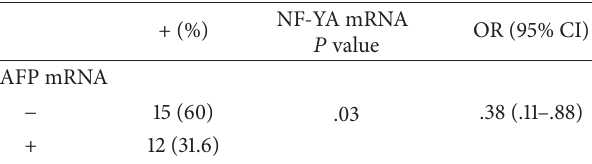
Table 6: Relationship between NF-YA and AFP mRNA expression in HCC